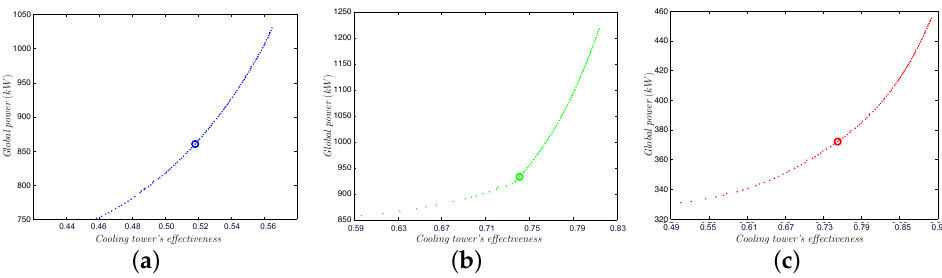
Figure 4. Pareto fronts and selected optimal solutions for 3 of the 35 operating points used in the implementation of the optimization with SPEA2 with stopping criterion after 90 s. ( a ) Operational point 8; ( b ) Operational point 16; ( c ) Operational point 26.